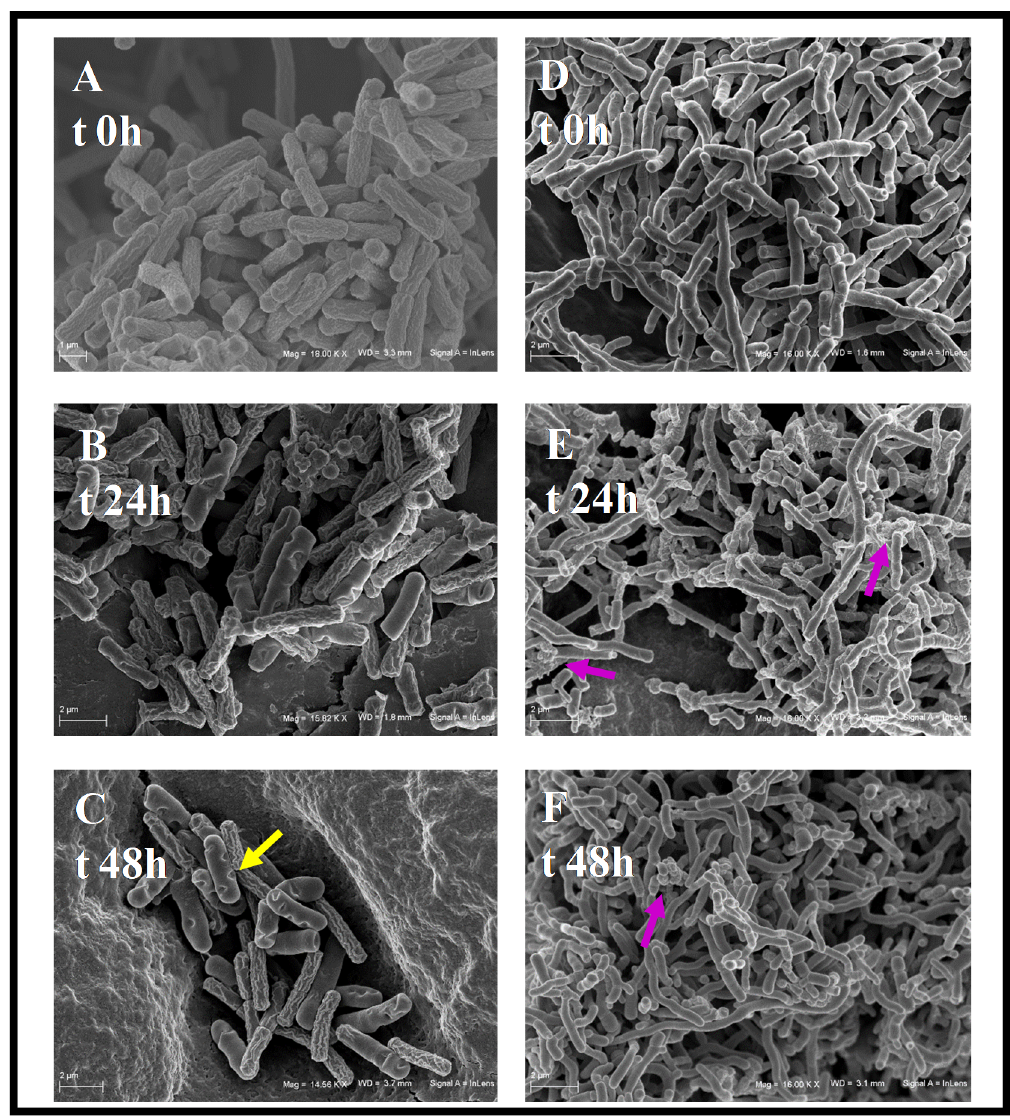
Figure 4. Changes of cell morphology at different time points of the growths and of the bioconversion processes of A. simplex ( A – C ) and S. roseochromogenes cells ( D – F ) detected by scanning electron microscopy (~16,000, scale bar 1 or 2 µm). A. simplex introflections and concave notches are indicated by the yellow arrow, while the accumulation of material on S. roseochromogenes cell surface is indicated by purple arrows.